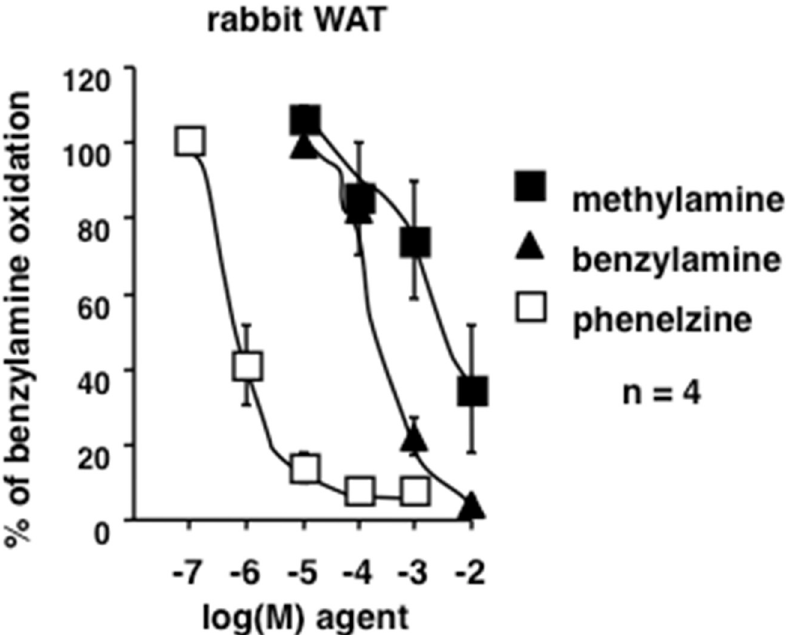
Figure 7. Competition by phenelzine and natural amines of the [ 14 C]-benzylamine oxidation by rabbit white adipose tissue (WAT) preparations. Rabbit WAT homogenates were incubated for 30 min in the presence of 0.5 mM [ 14 C]-benzylamine without (100%) or with increasing concentrations of phenelzine (open squares), benzylamine (black triangles), or methylamine (black squares). Mean ± SEM of four observations.